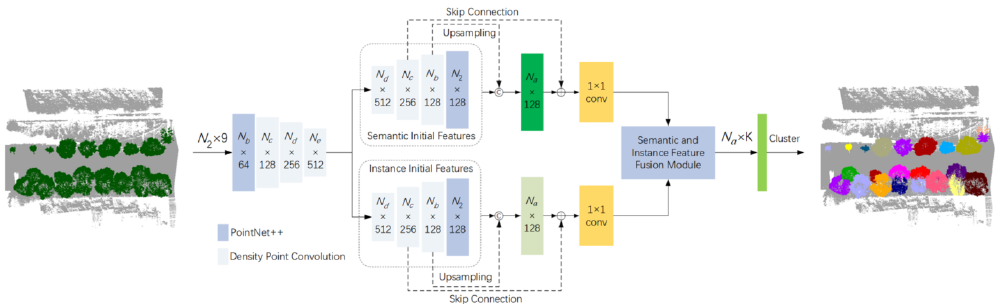
Figure 2. The overview of the proposed individual tree segmentation method.